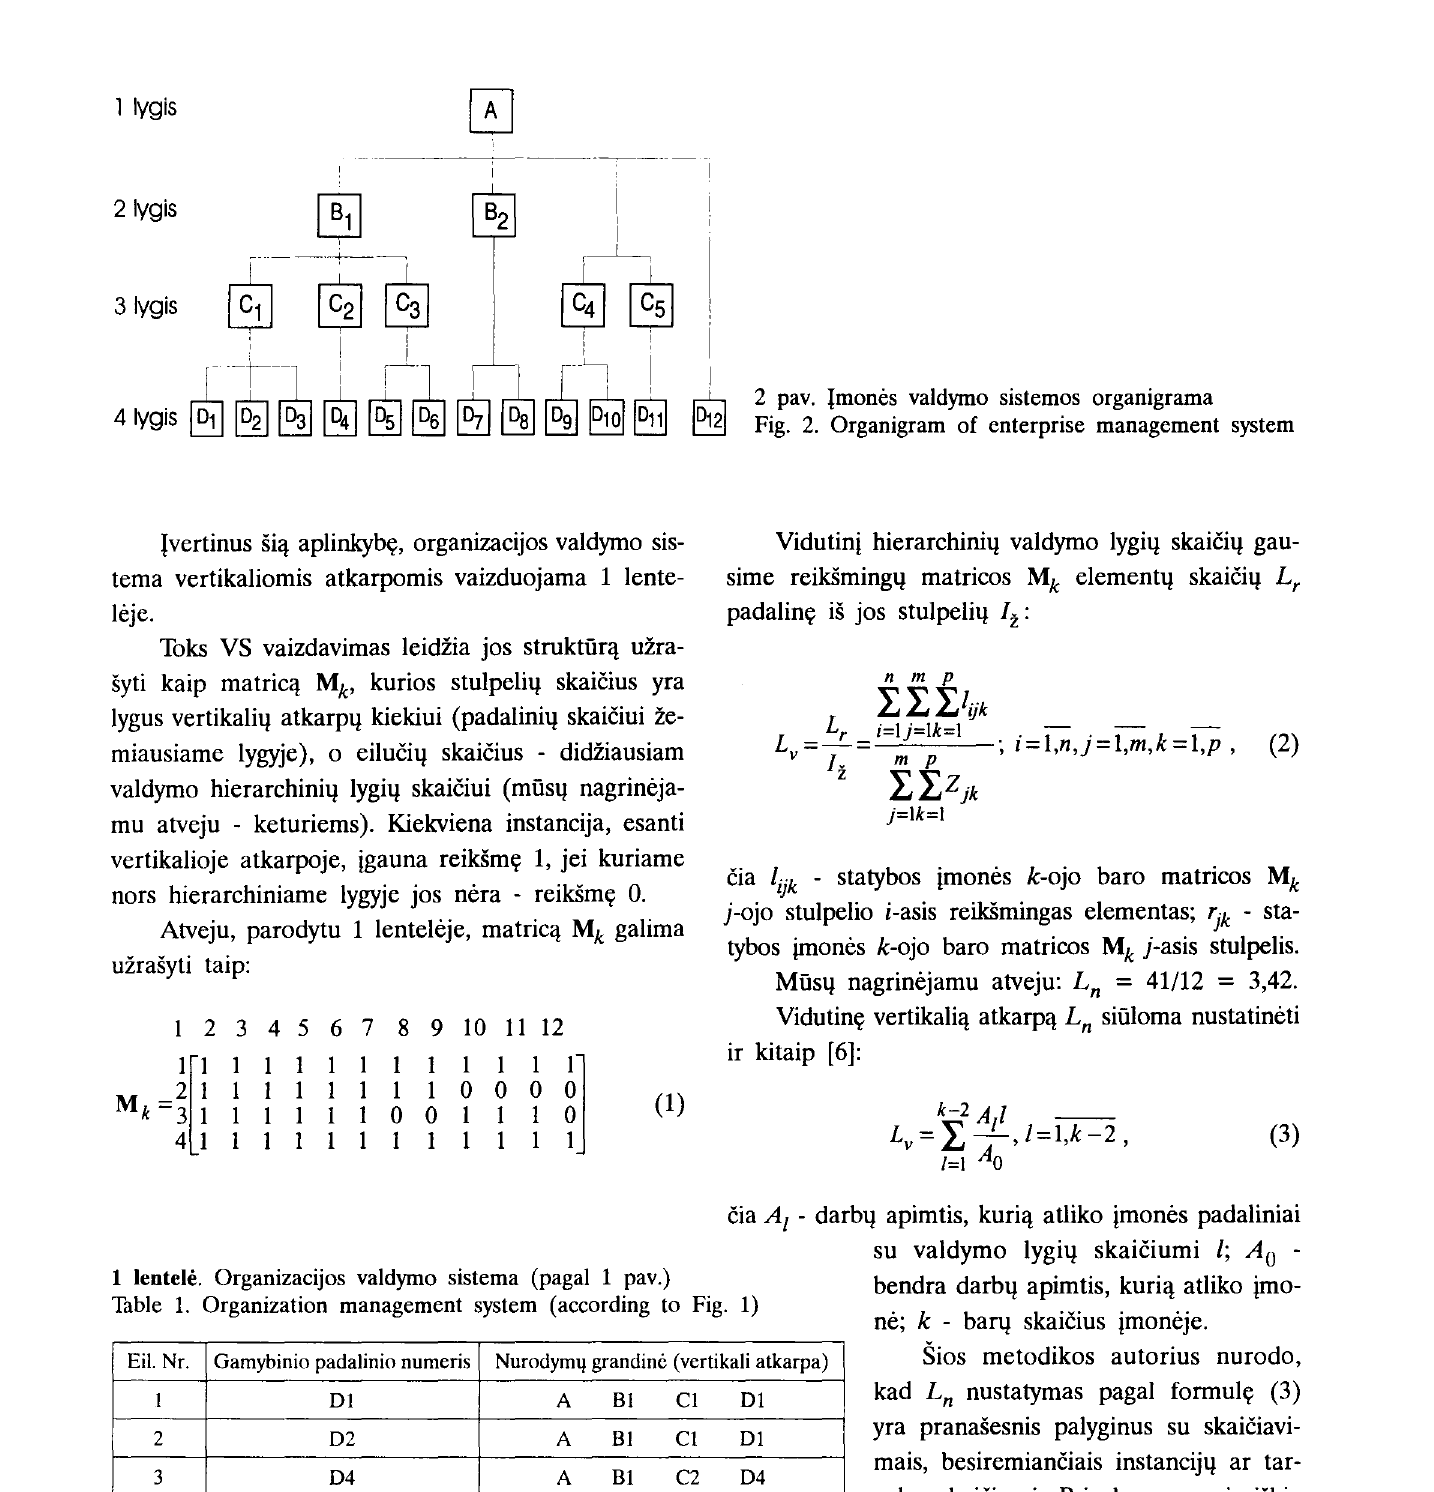
Table 1. Organization management system (according to Fig. 1)